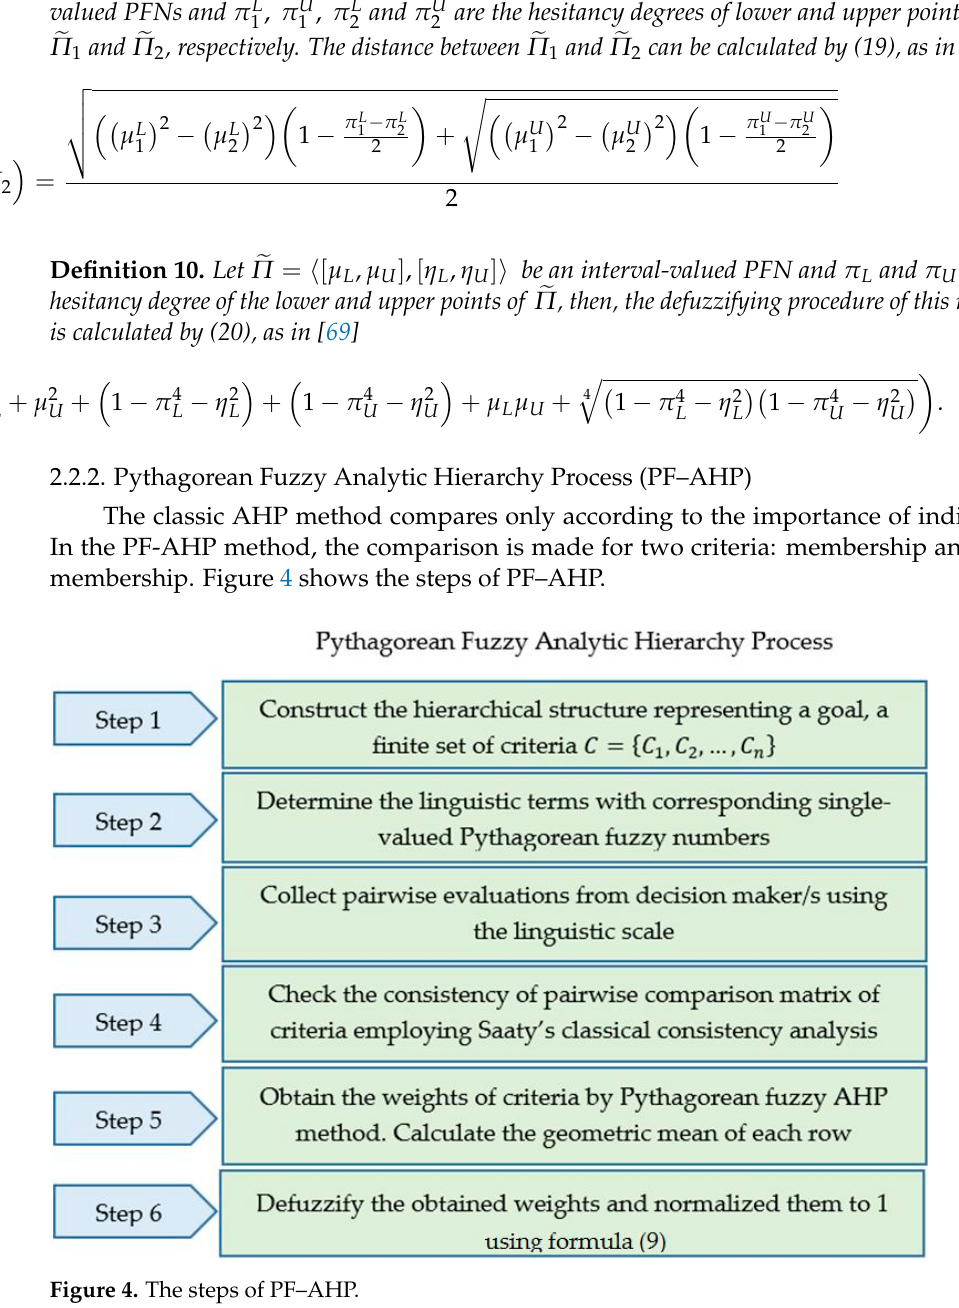
Figure 4. The steps of PF–AHP.